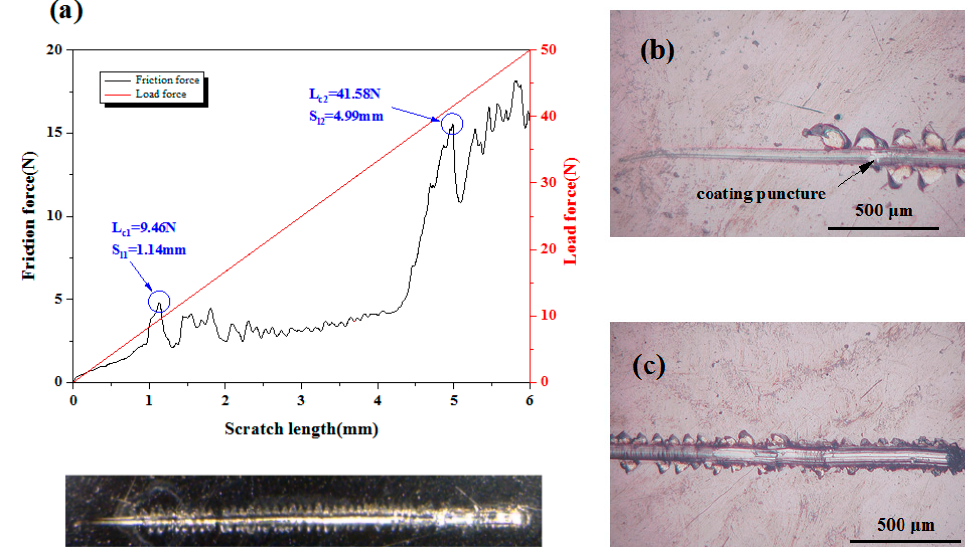
Figure 9. (a) Friction force and load force as a function of scratch length for ZnO-TaxOy coatings, (b) scratch starting position, and (c) scratch end position.